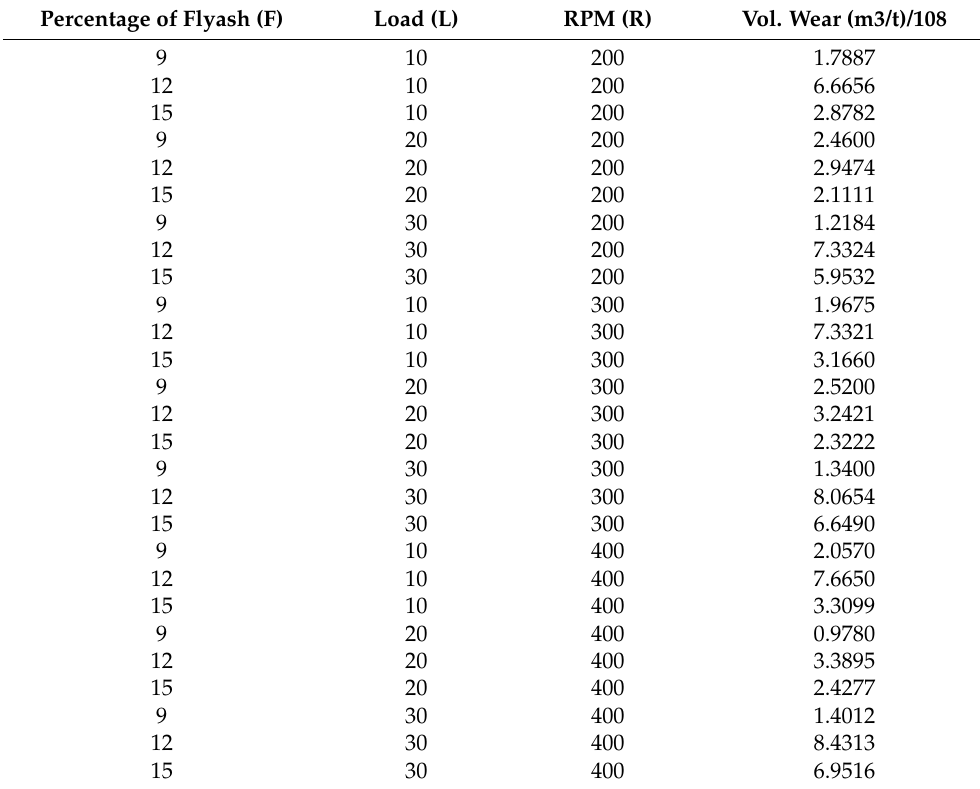
Table 5. Actual experimental data.